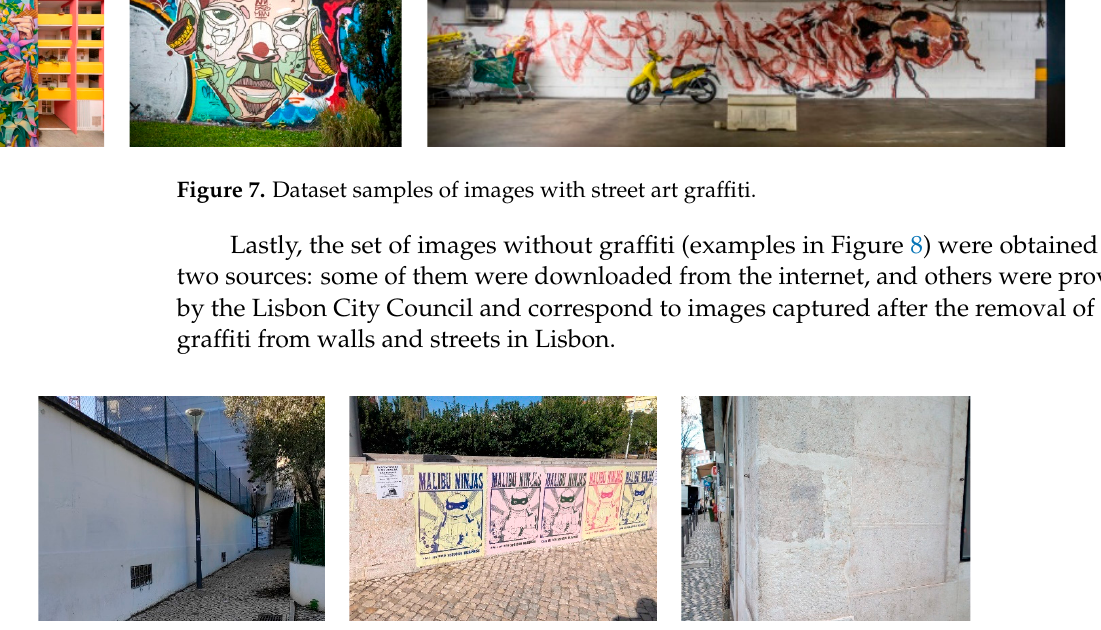
Figure 8. Dataset samples of images without graffiti.